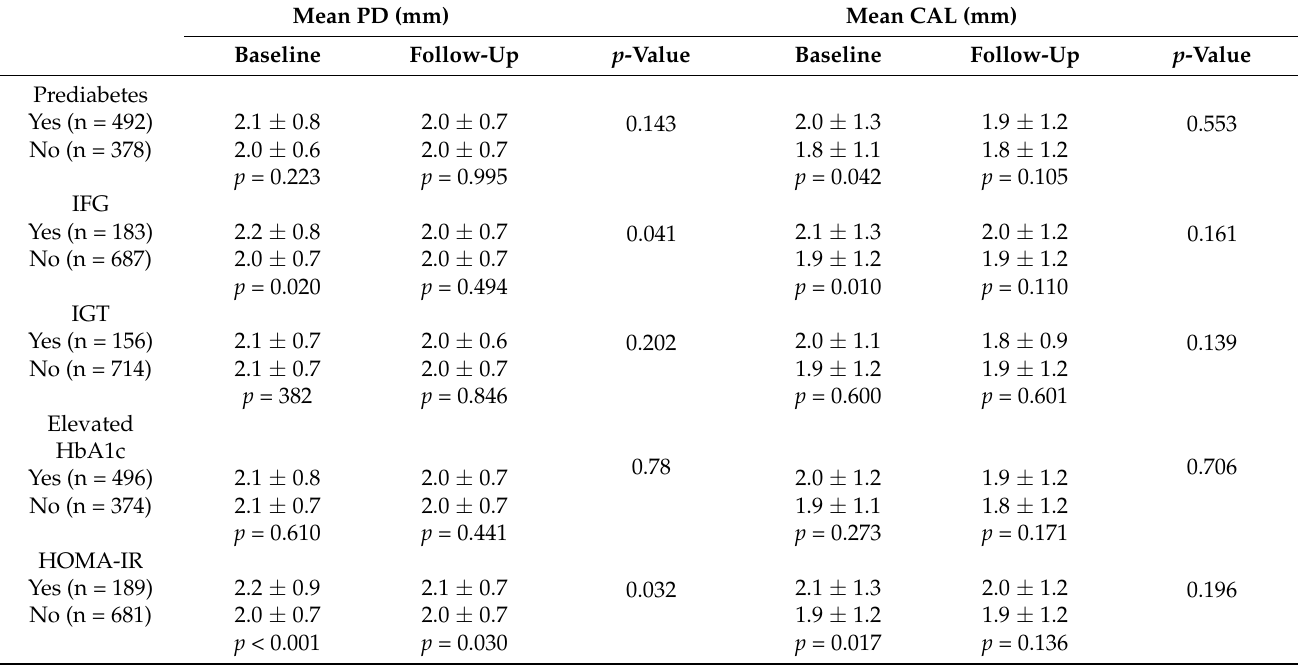
Table 2. Mean levels of pocket depth (PD) and clinical attachment loss (CAL) at baseline and follow-up visits according to impaired glucose metabolism